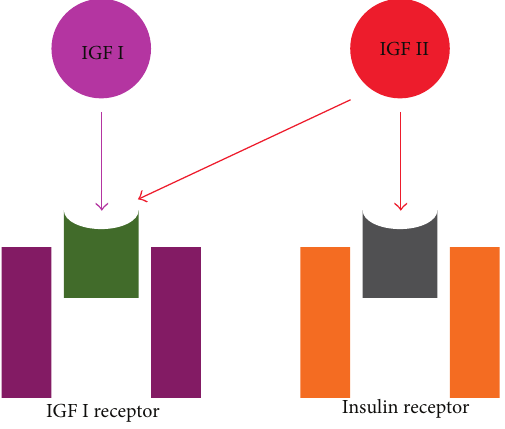
Figure 2: Mechanism of action of IGF